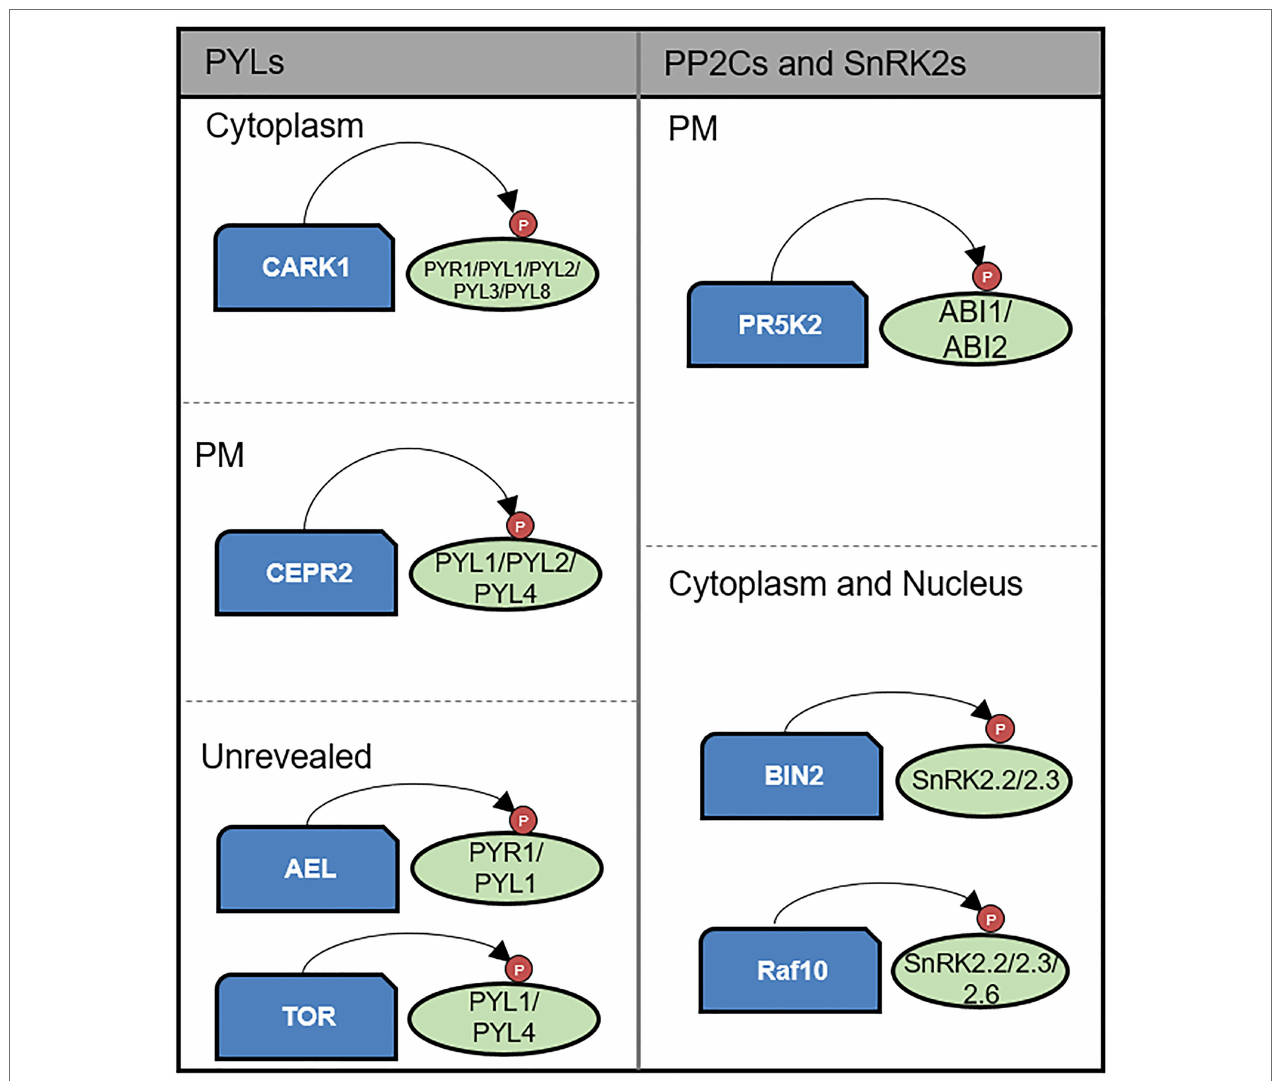
FIGURE 2 | Kinase-mediated post-translational modification of core components of the ABA signaling pathway. CARK1, CEPR2, TOR kinase, and AEL phosphorylate PYLs. CARK1 positively regulates ABA signaling by enhancing PYLs activity on the cytoplasm. In contrast, CEPR2 and AEL negatively regulate ABA signaling by promoting degradation of PYLs. TOR kinase also plays negative role in ABA signaling by preventing PYL activation. CEPR2 acts on PM. ABI1 and ABI2 are phosphorylated and enhanced in their phosphatase activity by PR5K2 on the PM. BIN2 and RAF10 phosphorylate SnRK2s enhancing their kinase activity on the cytoplasm and